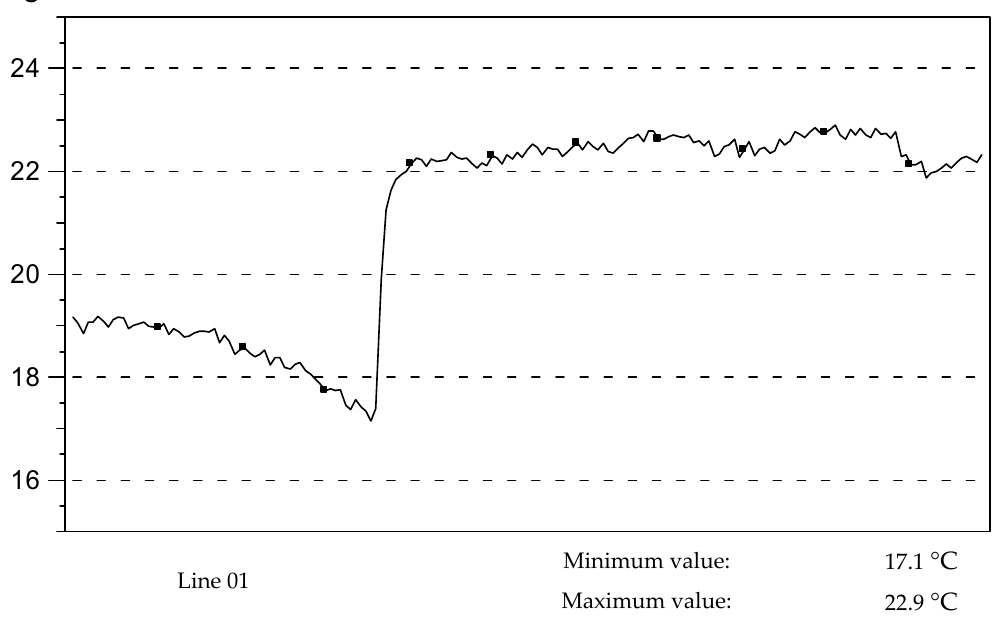
Figure 14. Temperature distribution along the line L 01.